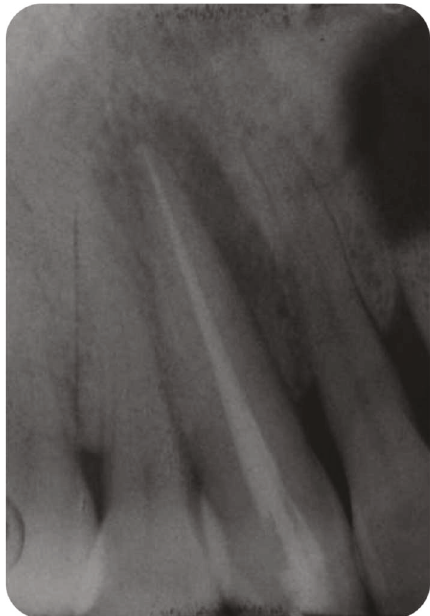
Figure 5: Disappearance of sealer pu ff two weeks after the endodontic therapy.